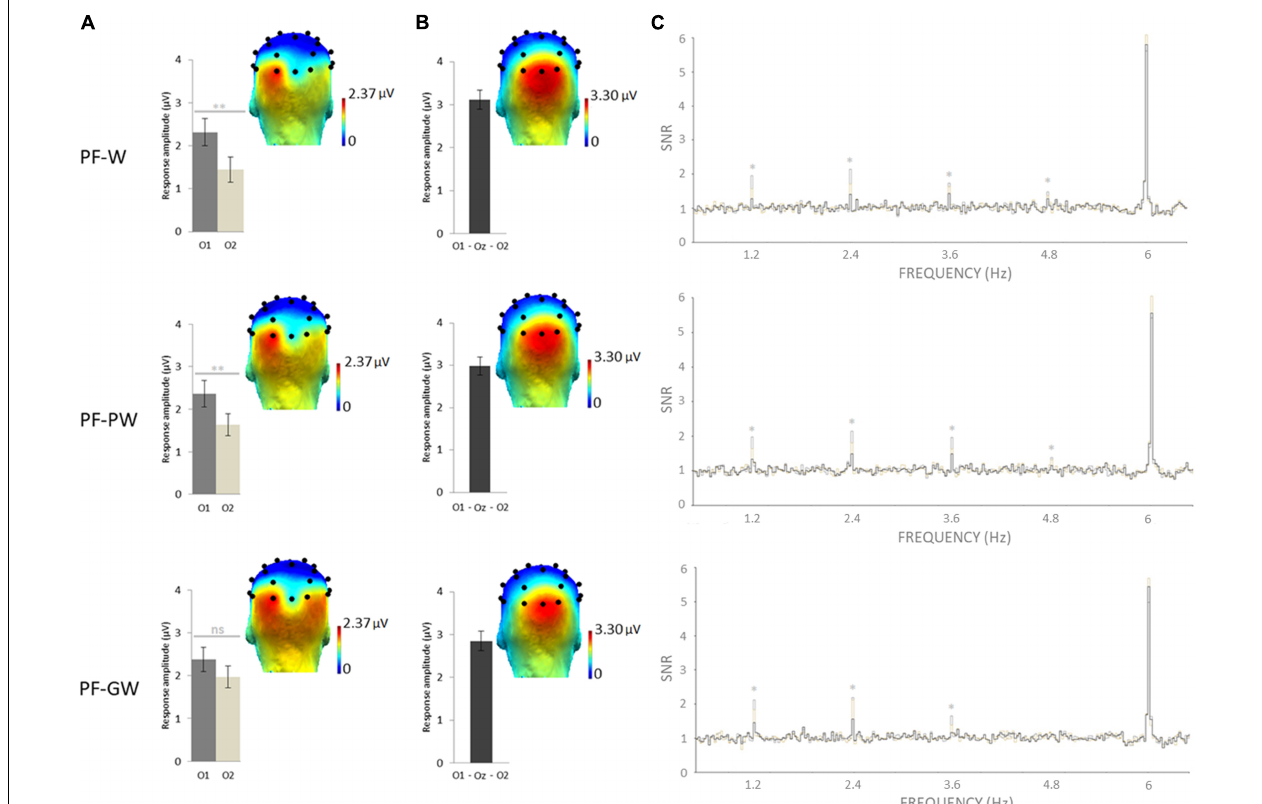
FIGURE 2 | Response amplitudes and topographies of the whole group. Grand-averaged ( N = 42) scalp topographies for the response in each condition at (A) the target and (B) base frequencies (sum of baseline subtracted amplitudes at significant harmonics; see section “Materials and Methods”). Histograms represent the same data, with standard errors of the mean. For letter strings-selective responses, stars indicate significant difference between the left (O1) and the right (O2) occipital electrodes ( ∗∗ p < 0.01, ns: not significant). (C) SNR EEG spectra on O1 (dark gray), O2 (in light gray), and Oz (in black) for each condition, stars indicate significant responses at letter strings-selective frequency and harmonics (1.2, 2.4, 3.6, and 4.8 Hz). Individual EEG data summarized in Figure 2 are provided in Supplementary Data Sheets S2–S4 , and described in Supplementary Data Sheet S1